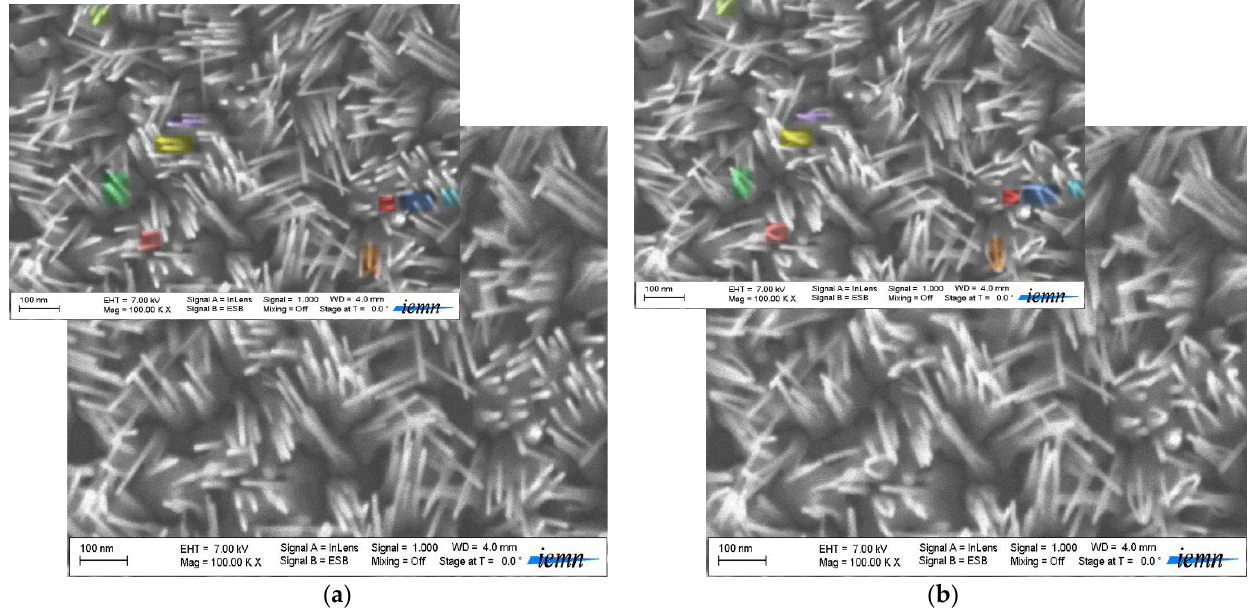
Figure 2. SEM Images top view of ZnO NWs grown at 10 Torr in Argon environment, 400 mJ for 15 min. ( a ) ZnO NWs by PLD on thin Glass + ITO + ZnO SL (before bending); ( b ) ZnO NWs by PLD on thin Glass + ITO + ZnO SL (after